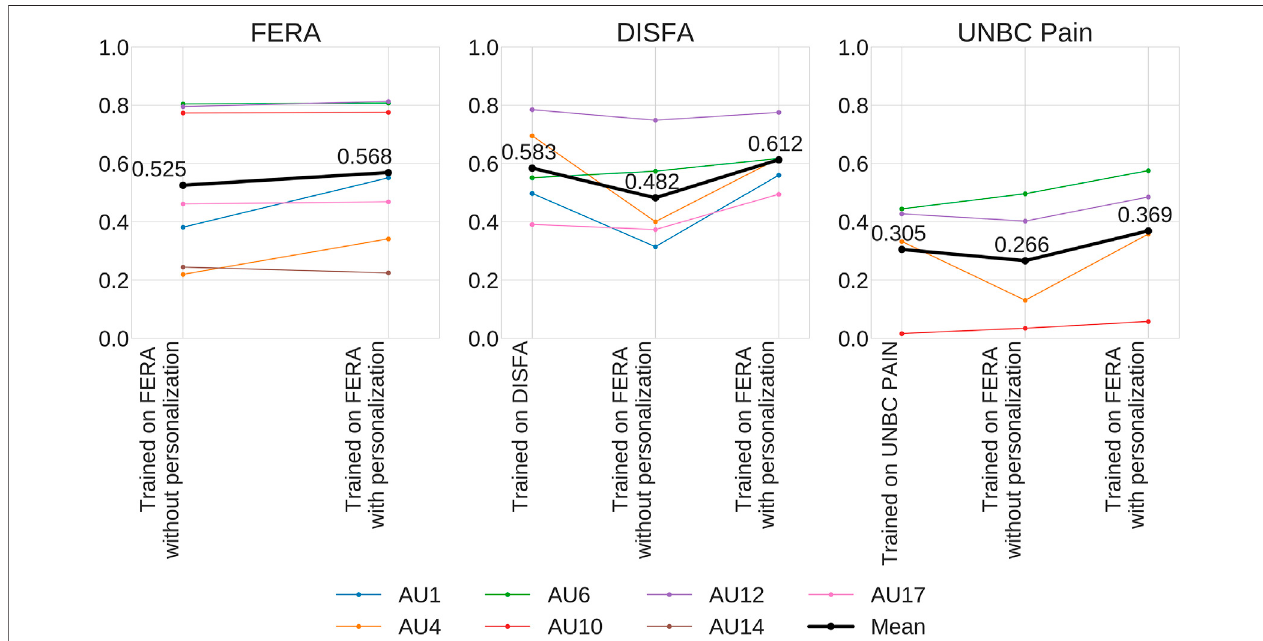
FIGURE6| ComparisonofICCbetweennetworkstrainedonthesame-domaindataset(DISFAorUNBCPain),networkstrainedonFERAwithoutpersonalization, and networks trained on FERA with personalization. Personalized networks outperform the others.